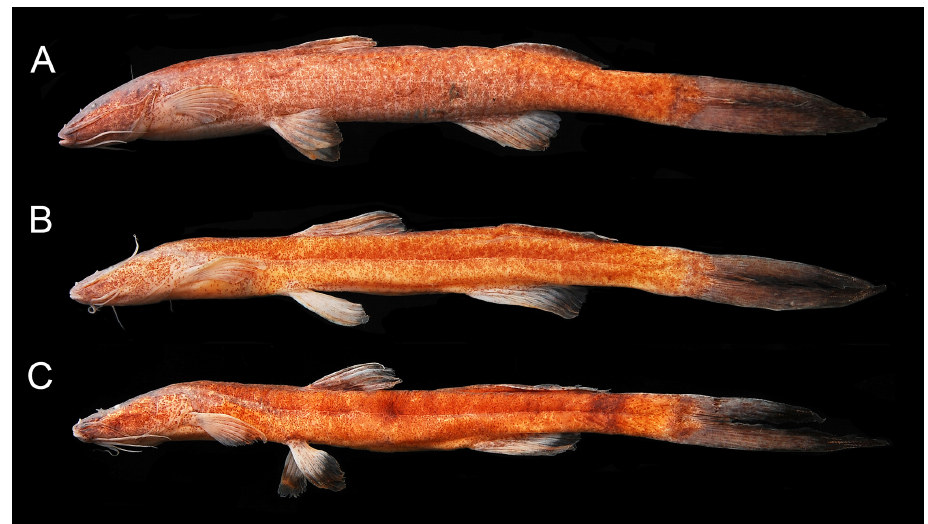
FIGURE 2 | Phenacorhamdia suia , paratypes, LBP 15886: A. 79.9 mm SL; B. 65.7 mm SL; C. 56.0 mm SL. Photographed by Lais